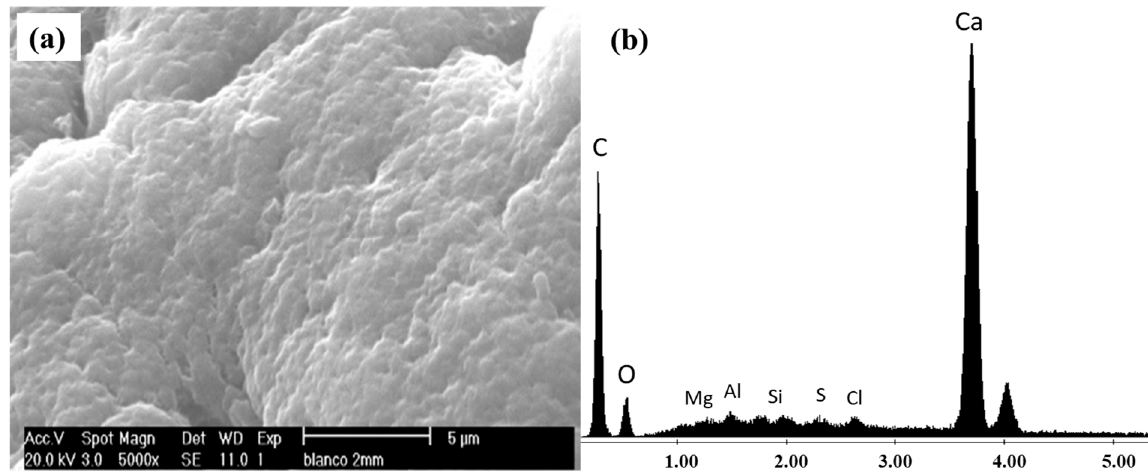
Figure 1. ( a ) SEM and ( b ) EDS analysis of virgin alginate beads.